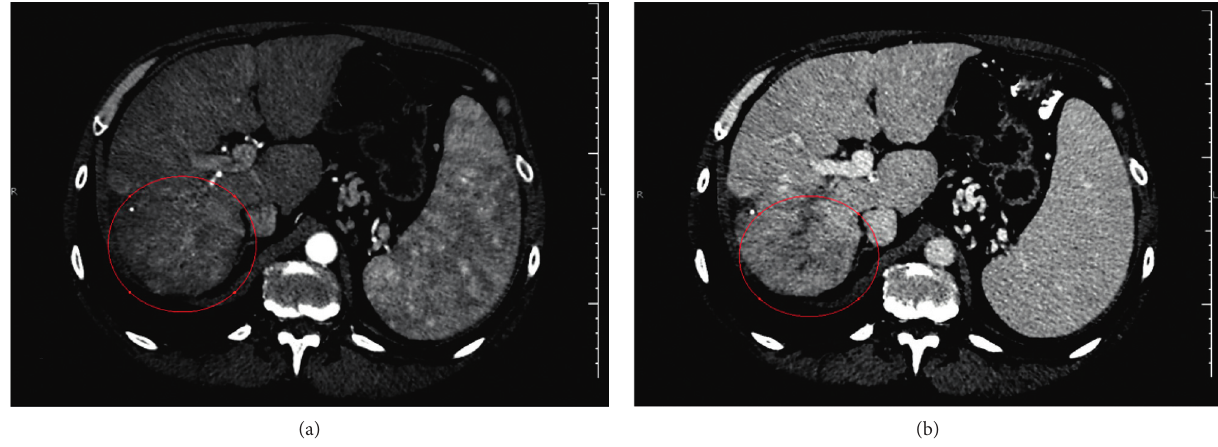
Figure 2: Computed tomography performed on October 1, 2018, showing the increase of the tumor dimensions. At this time, the tumor had 5.3cm and still had arterial phase enhancement. It had led to thrombosis of the right portal vein branch. The committed segment is underscored by the red circle. (a) Arterial phase. (b) Portal phase.